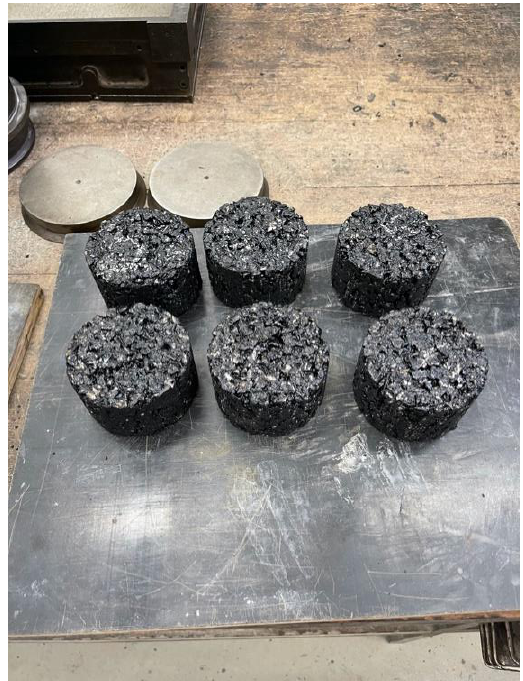
Figure 2. Marshall test samples.